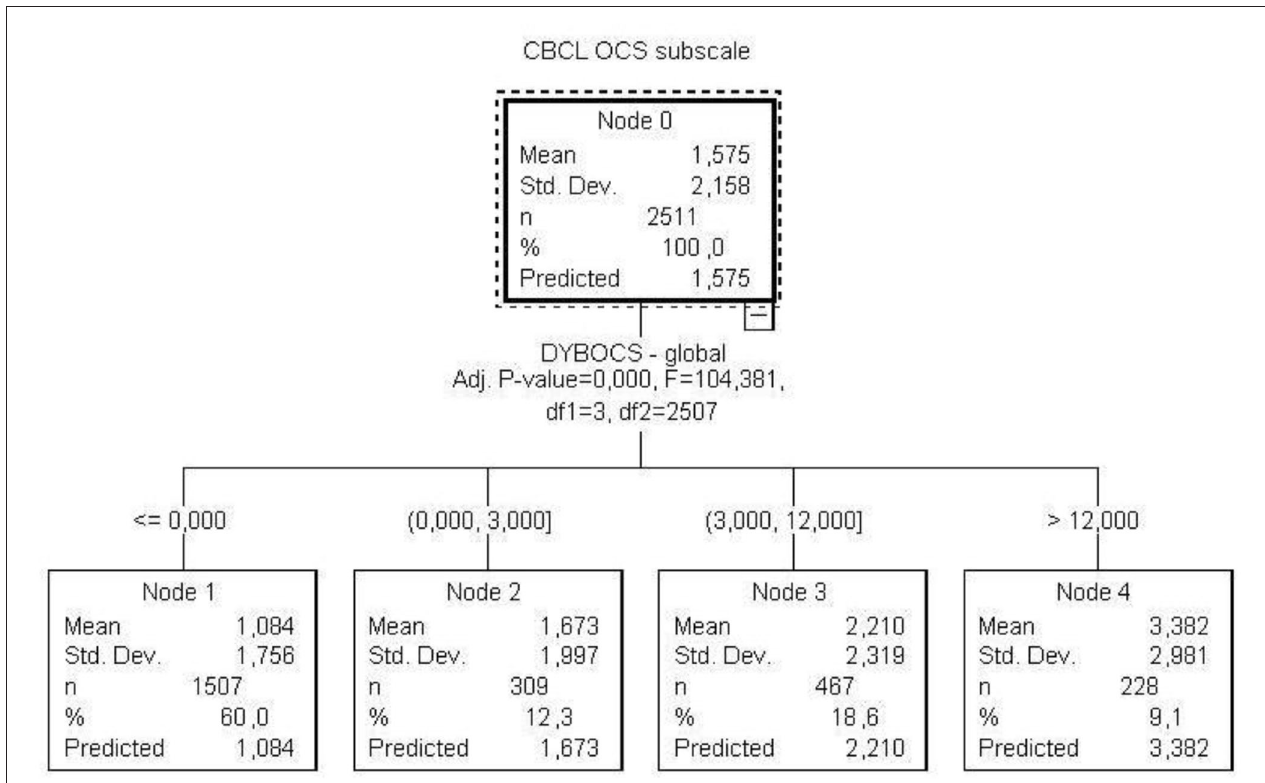
FIGURE 3 | Decision regarding maternal OCS global score and children’s